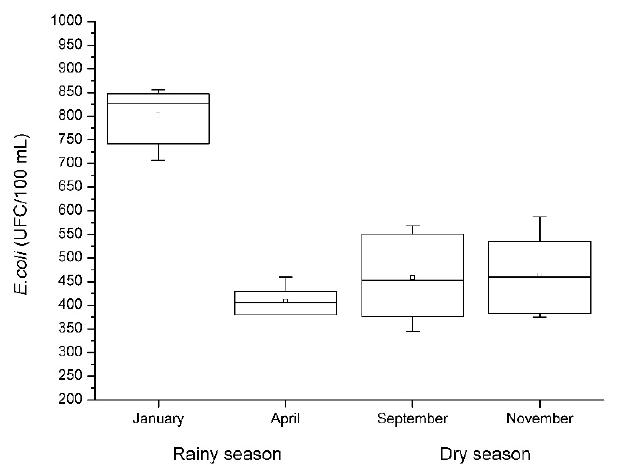
Figure 3. Box plots of E. coli analysis for the different seasons. Data collected (n = 6).